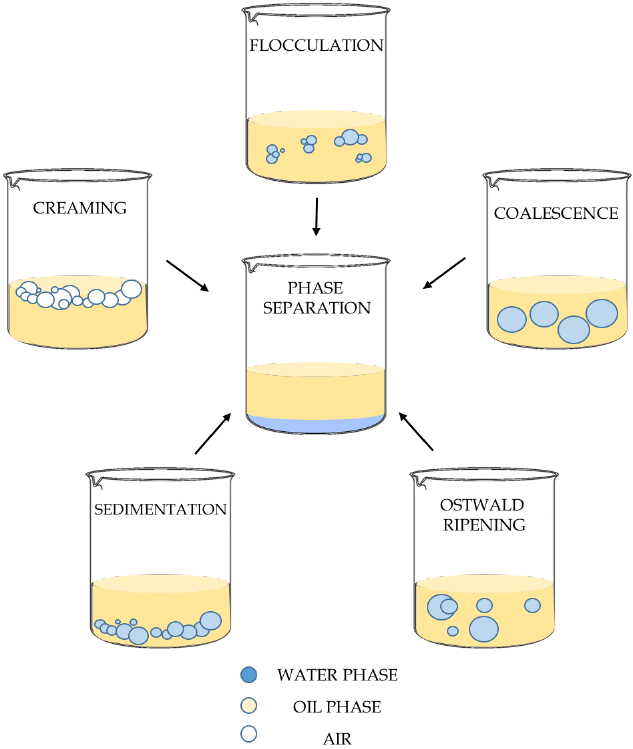
Figure 4. Di ff erent mechanisms of emulsion destabilization, depending on the particle size and dispersed phase concentration.